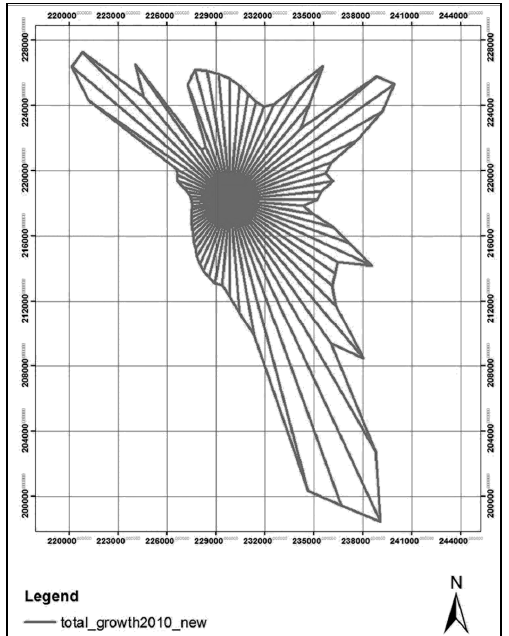
Figure 6. The succession of growth radiuses at θ = 5-degree angle for the 2010 stage using GIS. The TDNN is adopted for the prediction process in the following years: (1955, 1965, 1975, 1985, 1995, 2005, and 2015). However, as a result of emigration in 1967, the popula- tion density increased, and urban expansion increased rapidly. There was a large differ- ence between urban expansion in 1965 and 1975, which created illogical TDNN results. To eliminate the sudden jump, another experiment was performed by taking the years (1975, 1985, 1995, 2005 and 2015) as shown in Figure 7. Before the prediction process, the network was trained on the years 1975, 1985, 1995, and 2005 to predict 2015. However, in order for the data to be suitable for prediction, the growth radius was transformed into the percentage of growth by dividing the new radius over the older one each time, as in Equation (1). The average in most years was about 1.98. However, noticeably, in 1995– 2005, larger values were registered, which was possibly because of the increased immi- gration to Jordan in this period due to the regional turmoil and instabilities in neighboring countries.